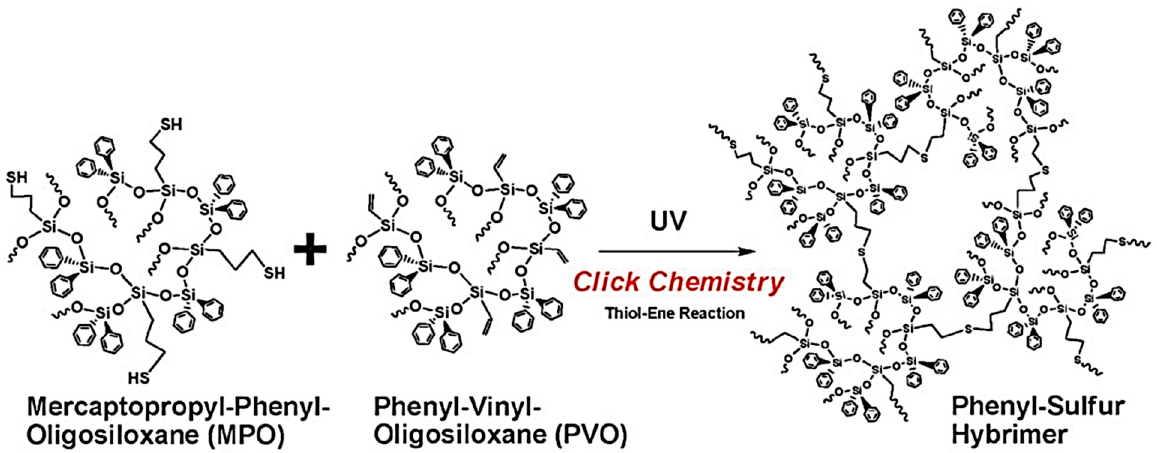
Figure 38. A new hybrid materials obtained by UV-initiated hydrothiolation. Reprinted/adapted with permission from Ref. [142].